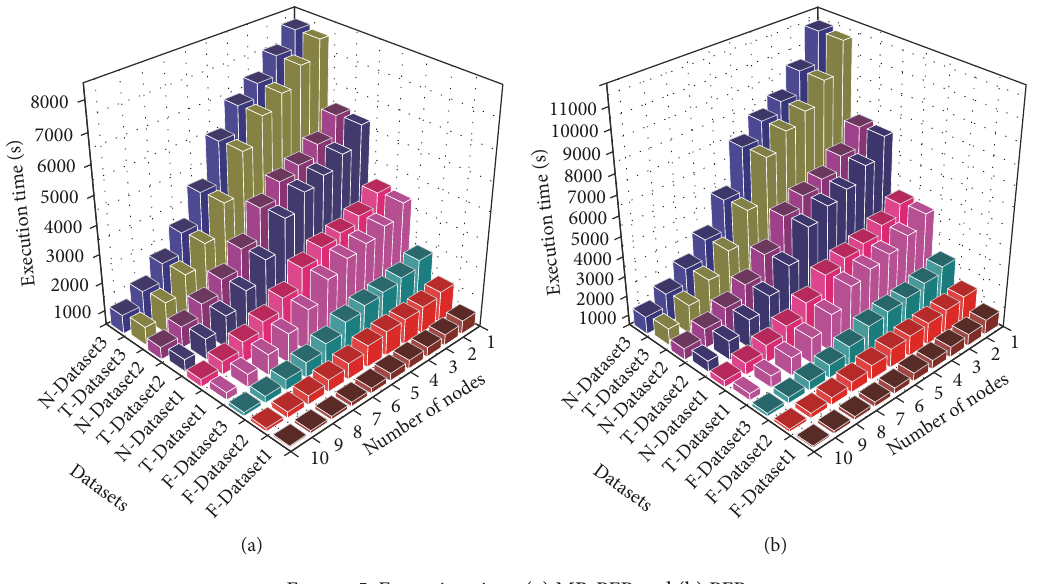
Figure 5: Execution time. (a) MR-PFP and (b)